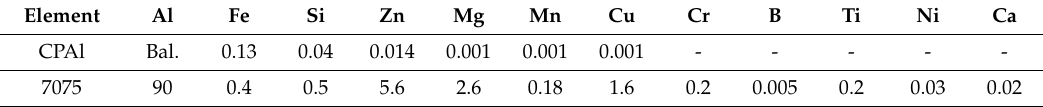
Table 1. Chemical composition of commercially pure aluminium (CPAl) and 7075 alloy powder (wt %). Element